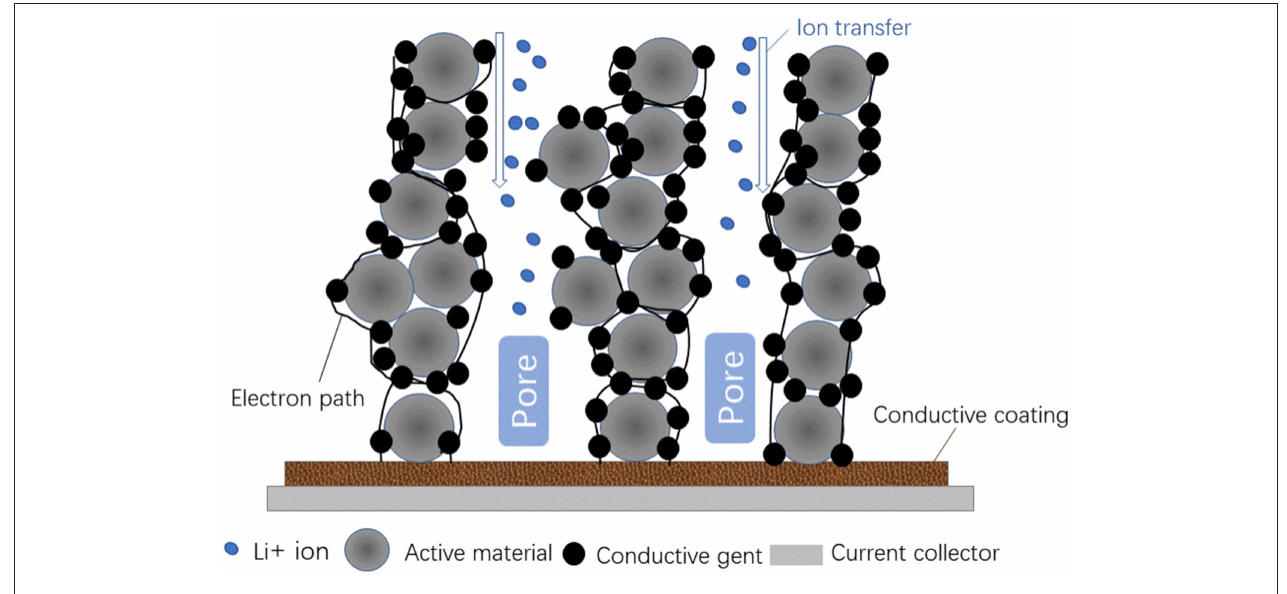
FIGURE 11 | Microstructure of the porous